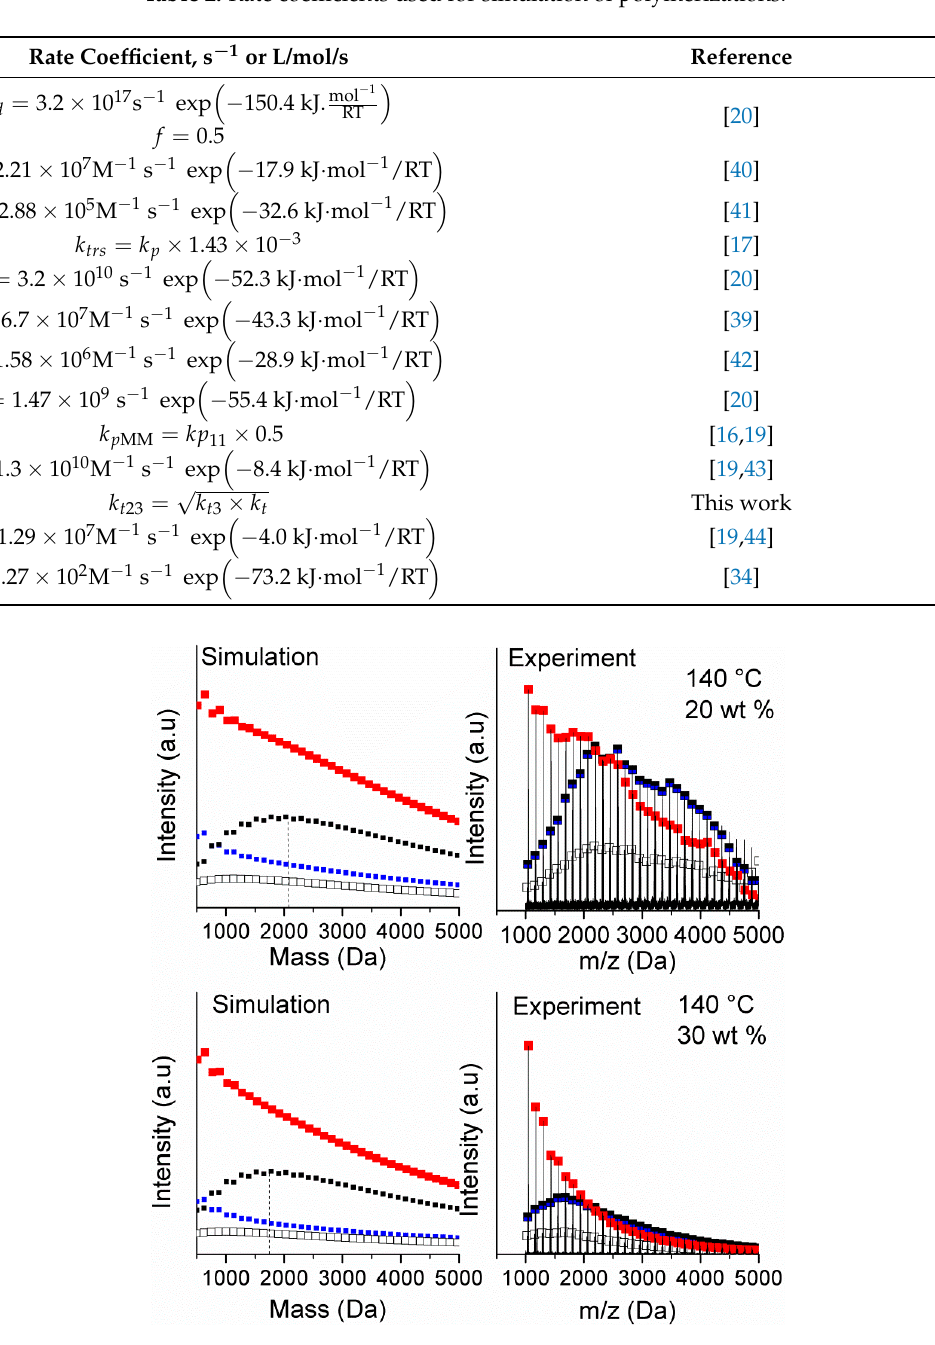
Figure 3. Experimental and simulated MALDI-TOF spectra at 20% (upper panel) and 30% (lower panel) and 140 °C. The experimental MALDI spectra show the complete experimental data (lines) and are overlayed with the assigned peaks using symbols corresponding to structures shown in Figure 1.